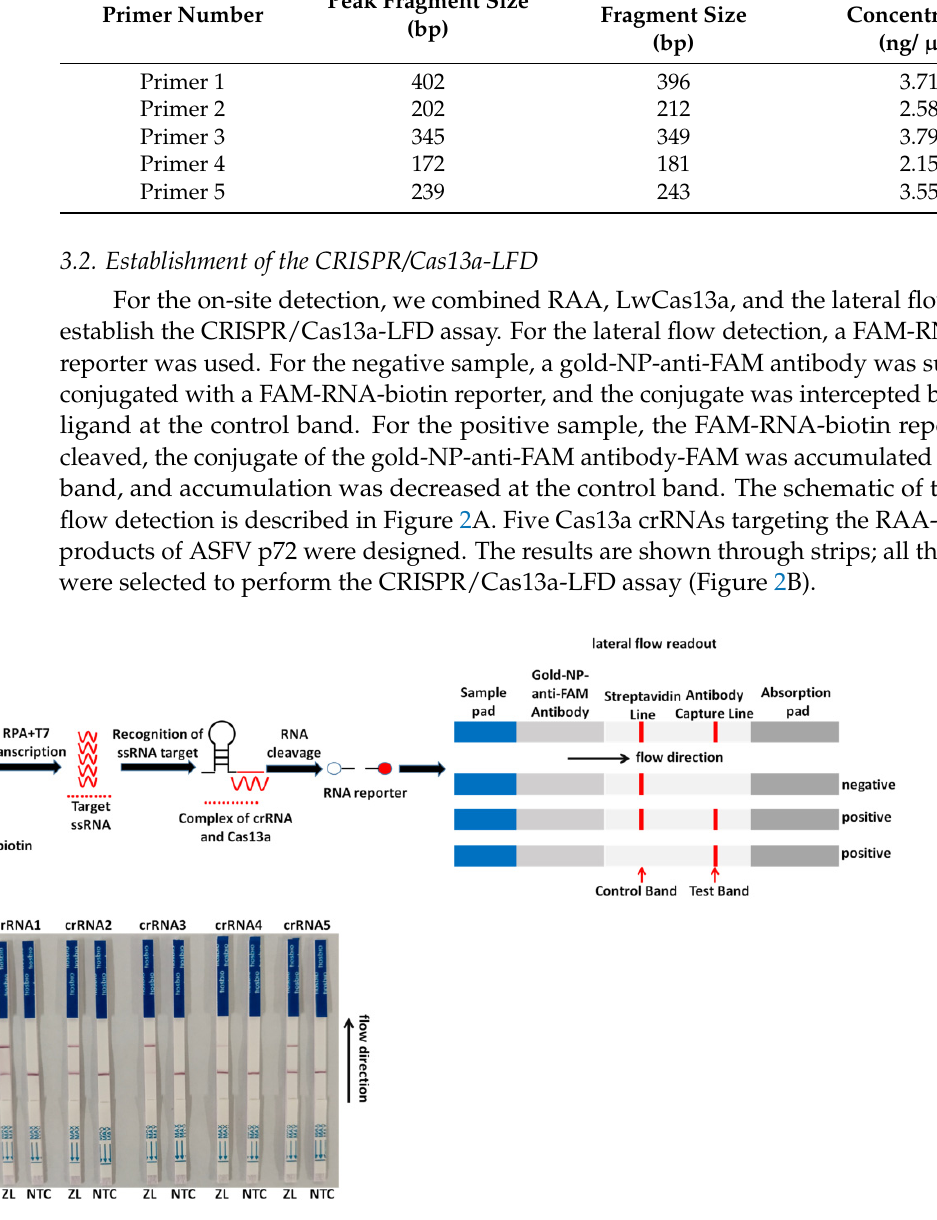
Figure 2. Establishment of the CRISPR/Cas13a-LFD. ( A ) Schematic diagram in the whole process of the CRISPR/CRISPR-associated 13 (Cas13a)-LFD detection. The P72 gene in the ASFV genome is amplified by RAA and then transcribed into RNA, which activates the Cas13a nuclease after being recognized by crRNA. The activated Cas13a nuclease then cuts off the reporter molecule, and the reporter molecule can appear as a band on the test strip. ( B ) Analysis of different crRNAs by CRISPR/Cas13a-LFD. ZL, pUC57-p72 standard plasmid. NTC, negative control.